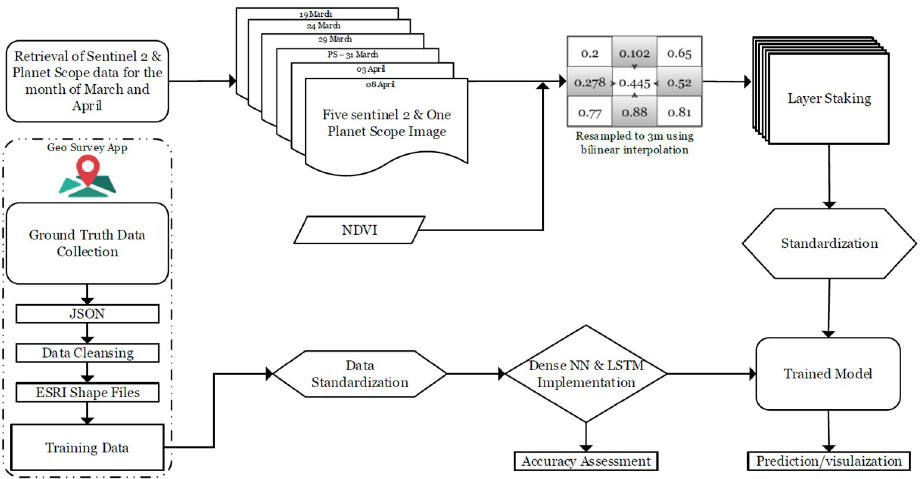
Fig 1. Schematic diagram describing the In-situ data preprocessing and overall data